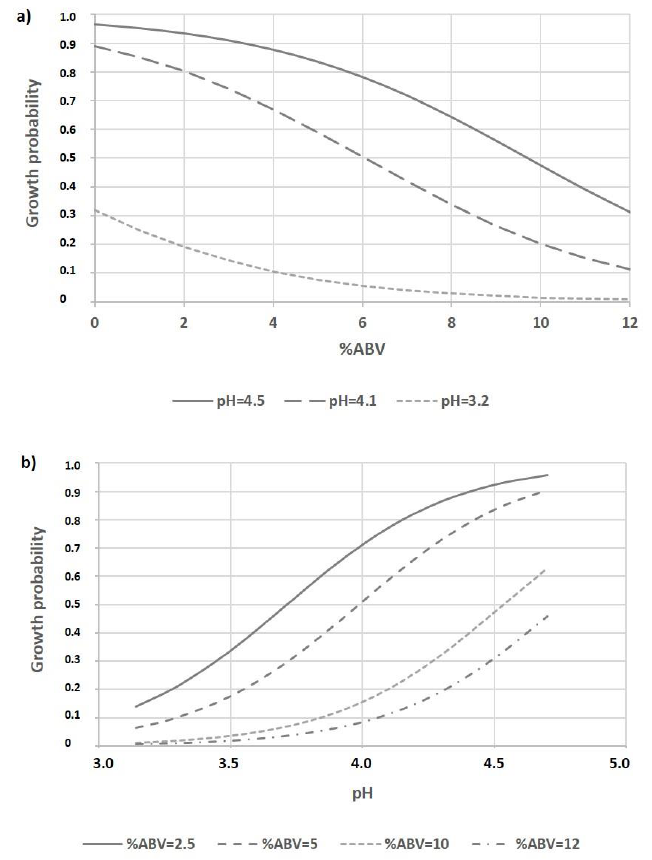
Figure 6. Predicted growth probabilities as a function of: ( a ) % ABV at different pH levels (3.2; 4.1; 4.5); ( b ) pH at different % ABV levels (2.5; 5; 10; 12). Values of % YFE and IBU were set at 2.37 and 30, respectively.